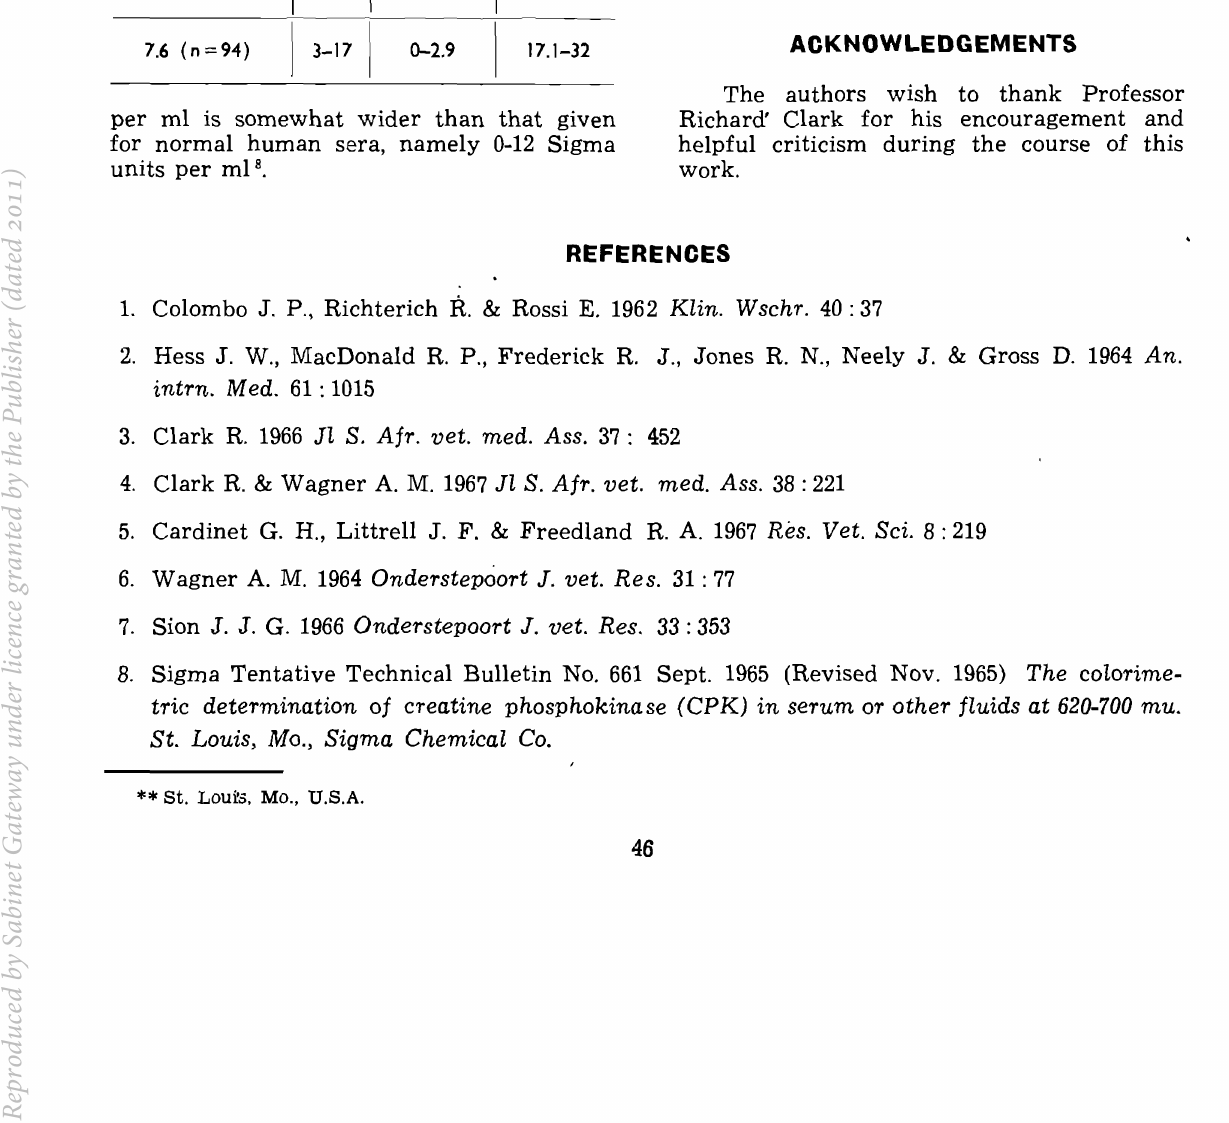
Fig. 2 Histogram of creatine phosphokinase levels of normal sheep.